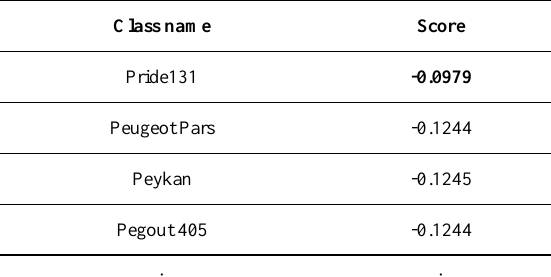
Figure 4. Sample test image. Table 1. Vehicle type identification using the first criterion